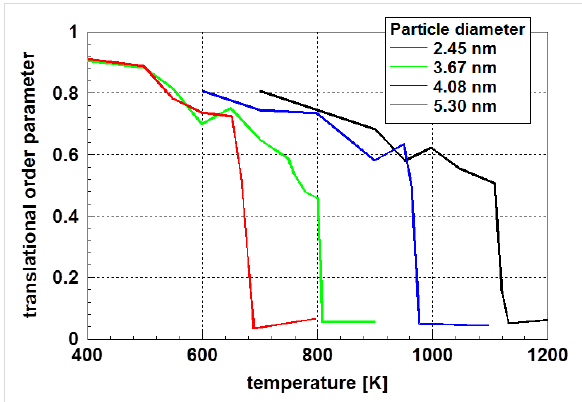
Figure 10: Translational order parameter for gold particles of different particle diameter as function of the temperature obtained by molecular dynamics simulations [47]. Even at a temperature significantly differ- ent from the melting temperature, perfect crystallization is not ob- served.